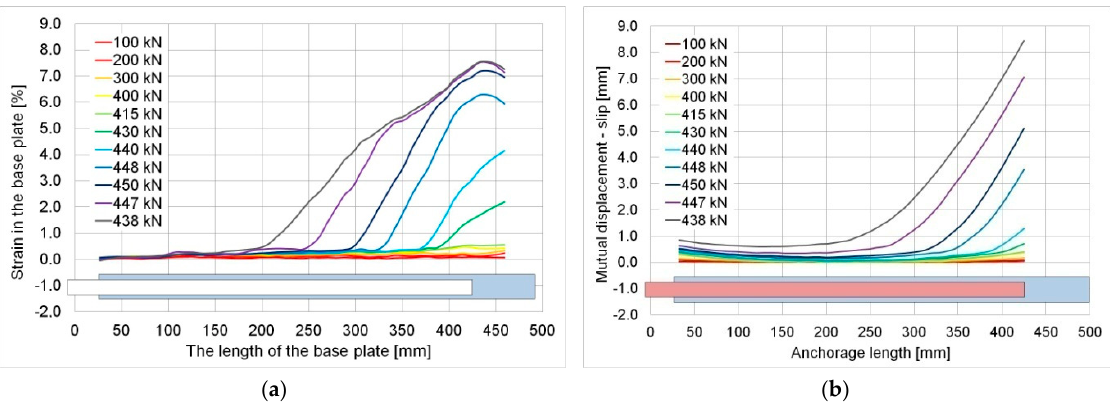
Figure 14. Strains determined over the whole overlap length, specimen S/DL/MA/RS-200-4/P2.